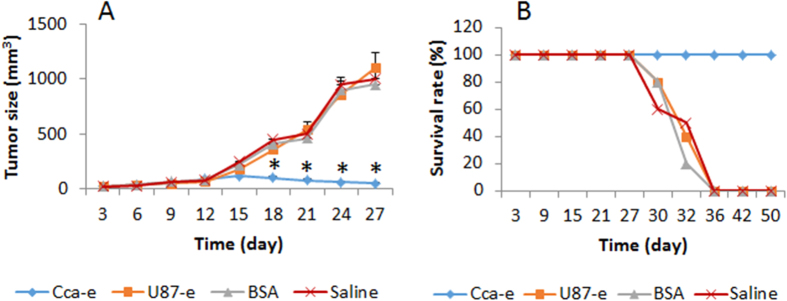
Effect of specific treatment on Cca mass size and weight.A–D, Cca-bearing mice were treated with Cca-e (extract)/alum, or U87-e/alum, or BSA/alum, or saline/alum. Cca mass was measured from day 3 to day 27. A, the curves indicate the tumor size on day 27. B, the curves indicate the survival rate of the tumor bearing mice. Each group consists of 10 mice. *, p < 0.01, compared with the saline group.